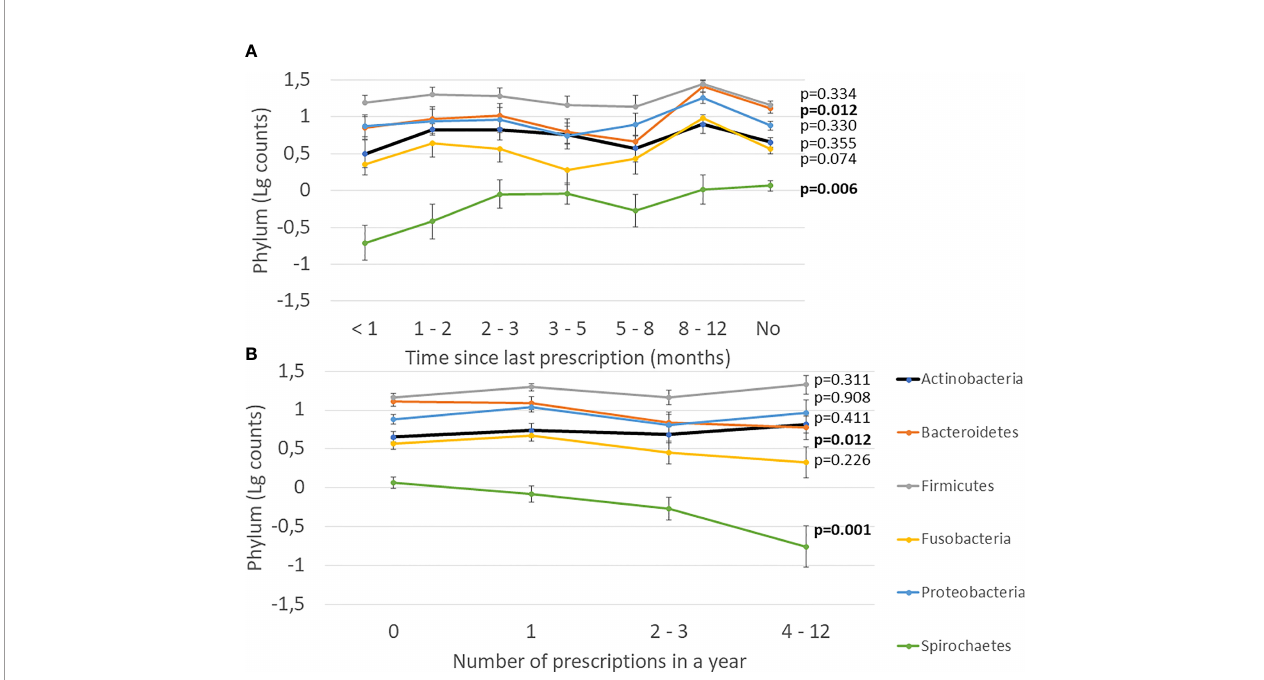
FIGURE 3 | Effect of antibiotics on subgingival microbiota. (A) Time since the last prescription. (B) Number of prescriptions during the preceding year. Mean values of log-transformed bacterial counts on the phylum level with the SE are shown. The p-values are for the weighted linear terms from